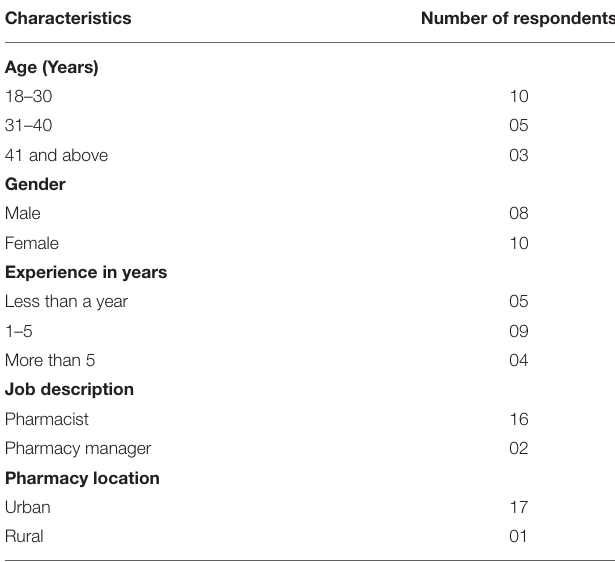
TABLE 1 | Demographic data of the